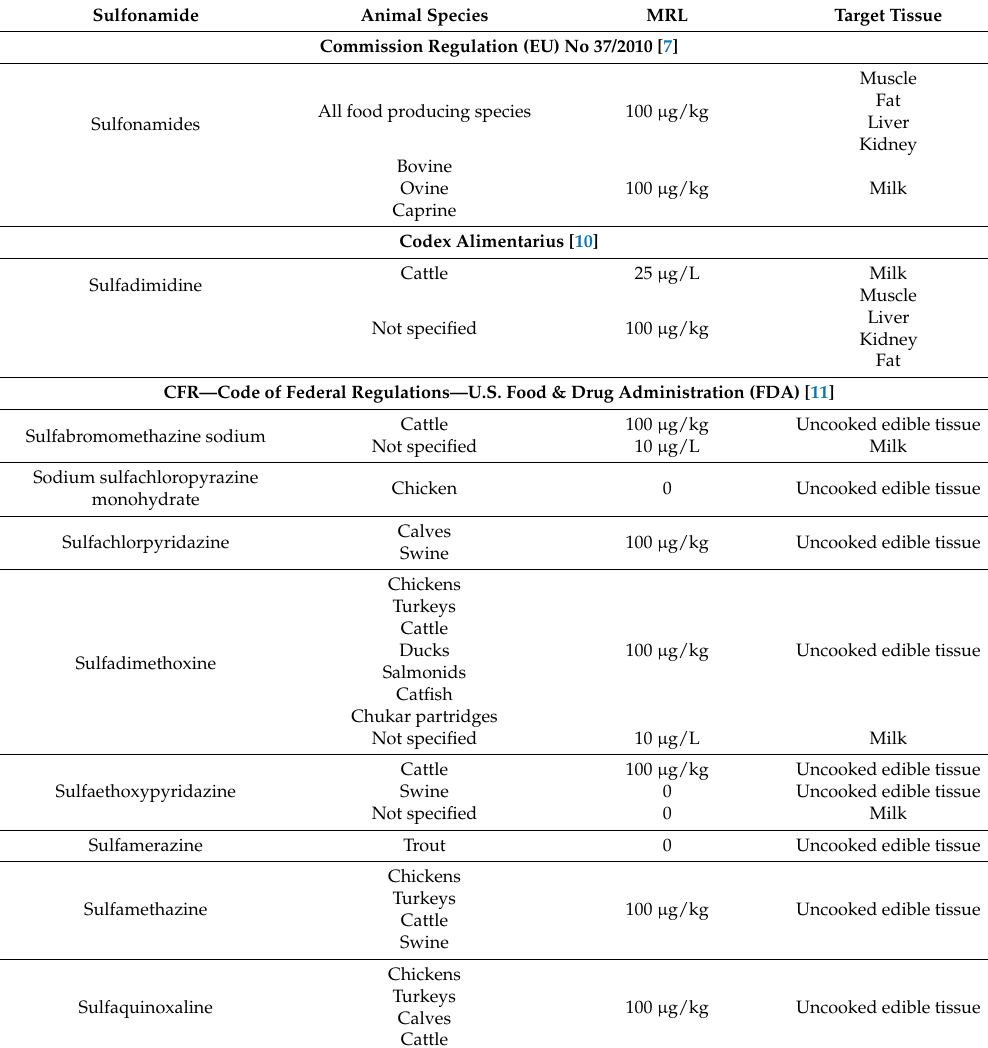
Table 1. MRLs for sulfonamide antibiotics, provided by the EU, Codex Alimentarius and